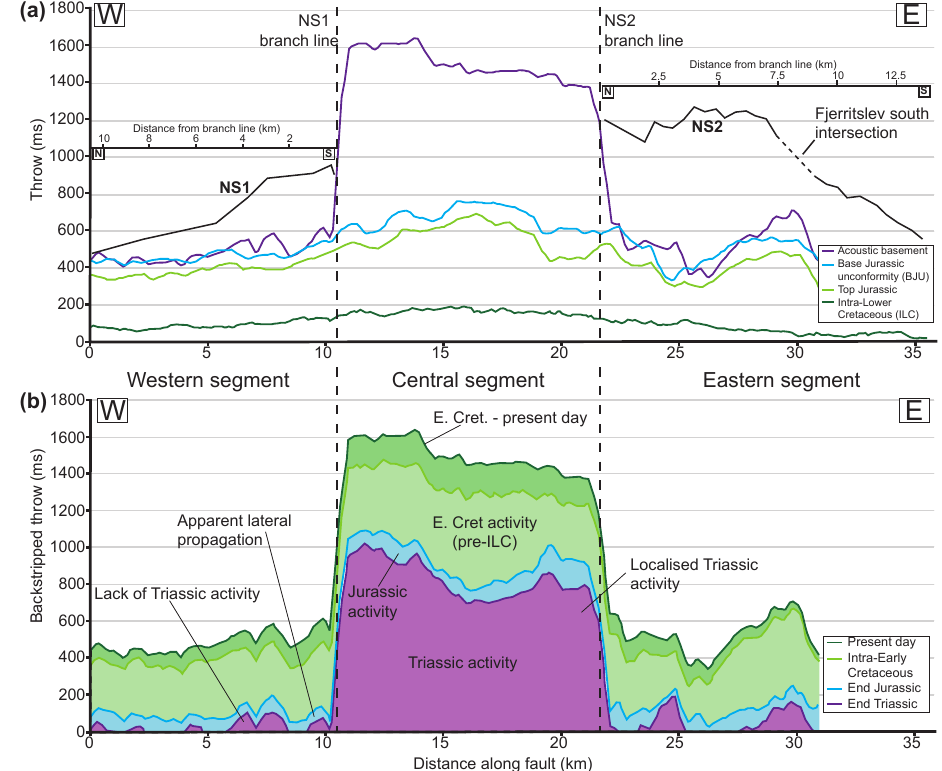
Figure 7. (a) Throw–length profiles calculated for major stratigraphic horizons along the Fjerritslev north fault showing the branch lines with other faults. Shown in black are the throw–length profiles for the NS1 and NS2 faults calculated across the acoustic basement horizon. Note the correspondence between the NS1 and NS2 fault branch lines and the marked increase in throw along the acoustic basement horizon. (b) Backstripped fault profile for the Fjerritslev north fault showing the kinematic evolution of the fault. The central segment accommodated throw during the Triassic, before the rest of the fault became active and throw accumulated along the length of the fault during the Early